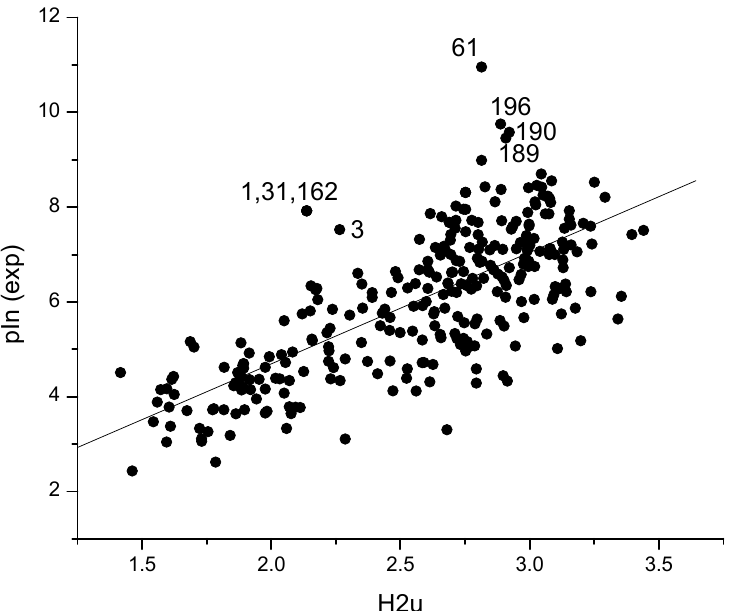
Figure 1. Dependence of pIn on the H2u index for 297 molecules; r = 0.719, S.E. = 1.05 and S.E. cv =1.05. Exclusion of outliers 1 , 3 , 31 , 61 , 162 , 189 , 190 and 196 from the regression yielded significantly better statistics: r = 0.764, S.E. = 0.93 and S.E. cv =0.94 ( N = 289).